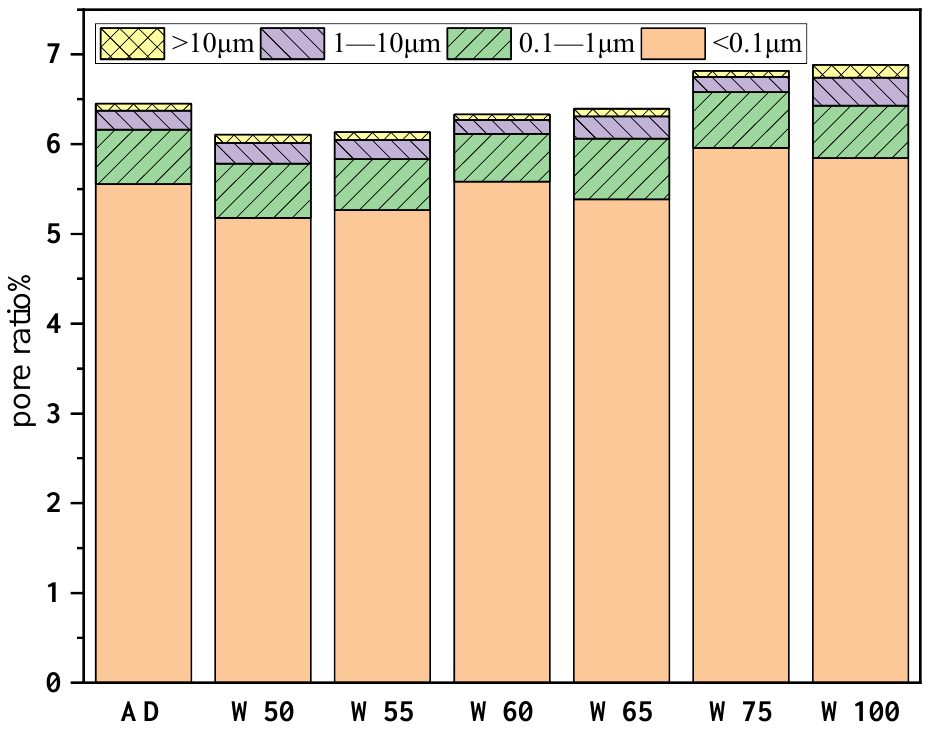
Figure 13. The proportion of pore diameter of recycled